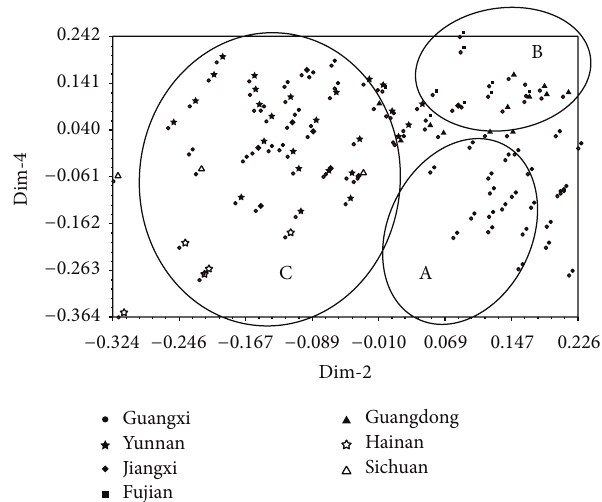
Figure 5: Principal components analysis of the 100 S. scitamineum isolates (numbers 1–100) based on SP-SRAP